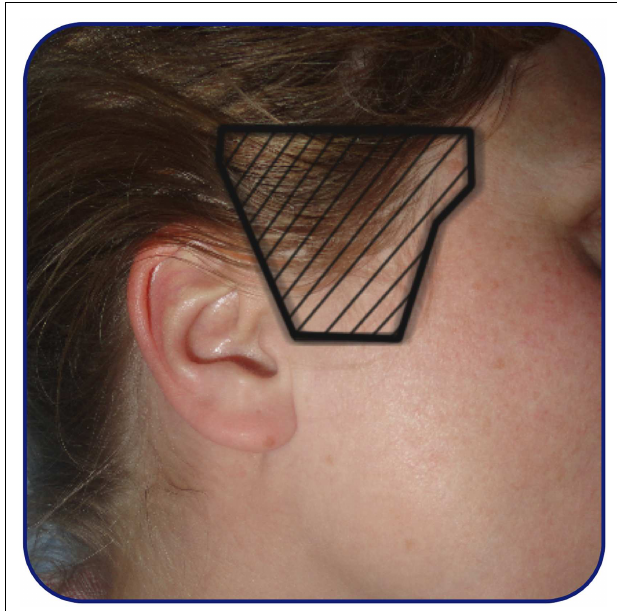
FIGURE 6 |Trans-temporal ultrasound window . Approximate location of the trans-temporal ultrasound window.